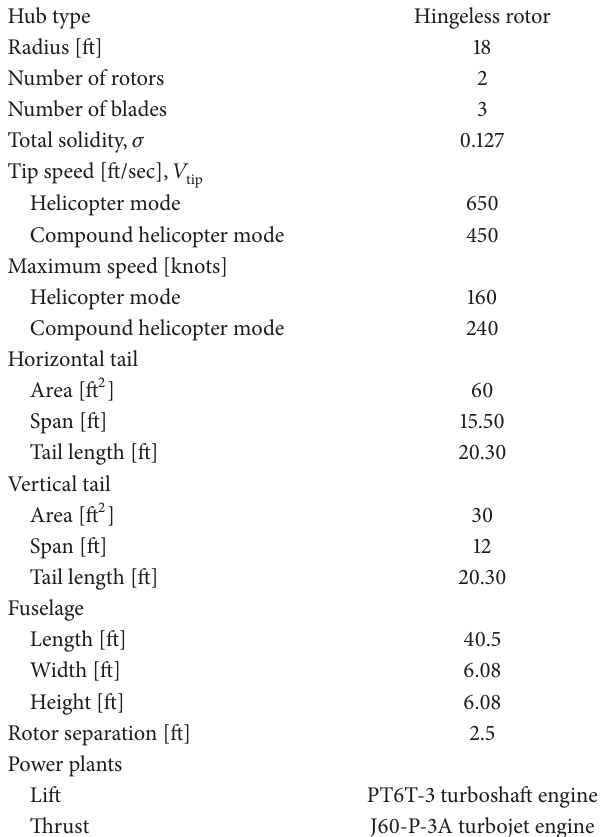
Table 1: General properties of XH-59A lift-offset compound heli-